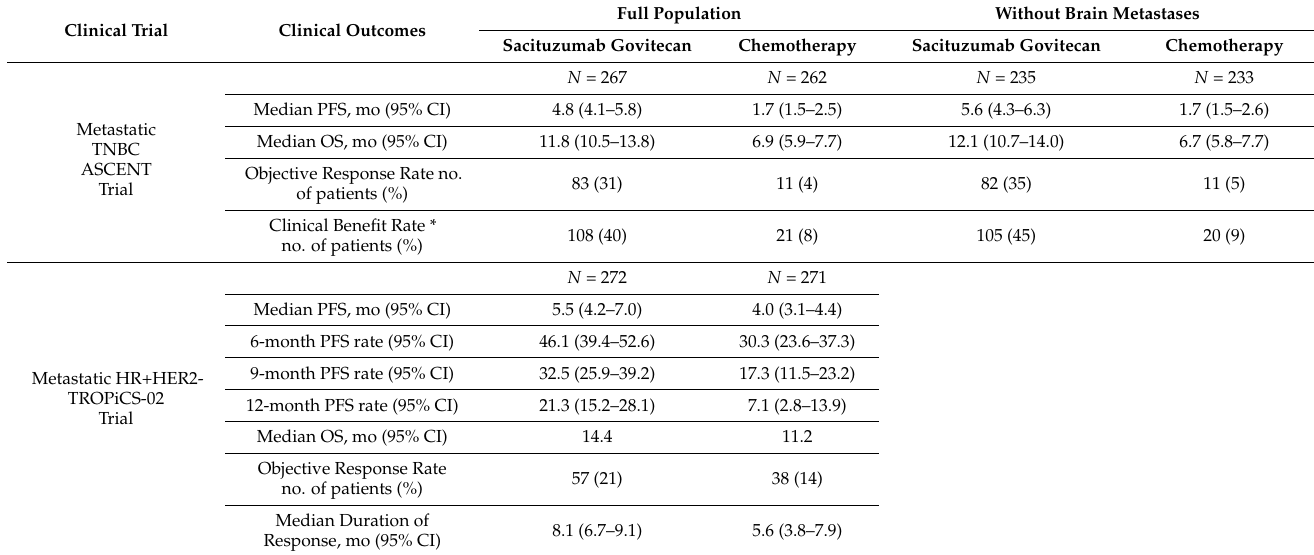
Table 1. Outcomes in the ASCENT and TROPiCS-02